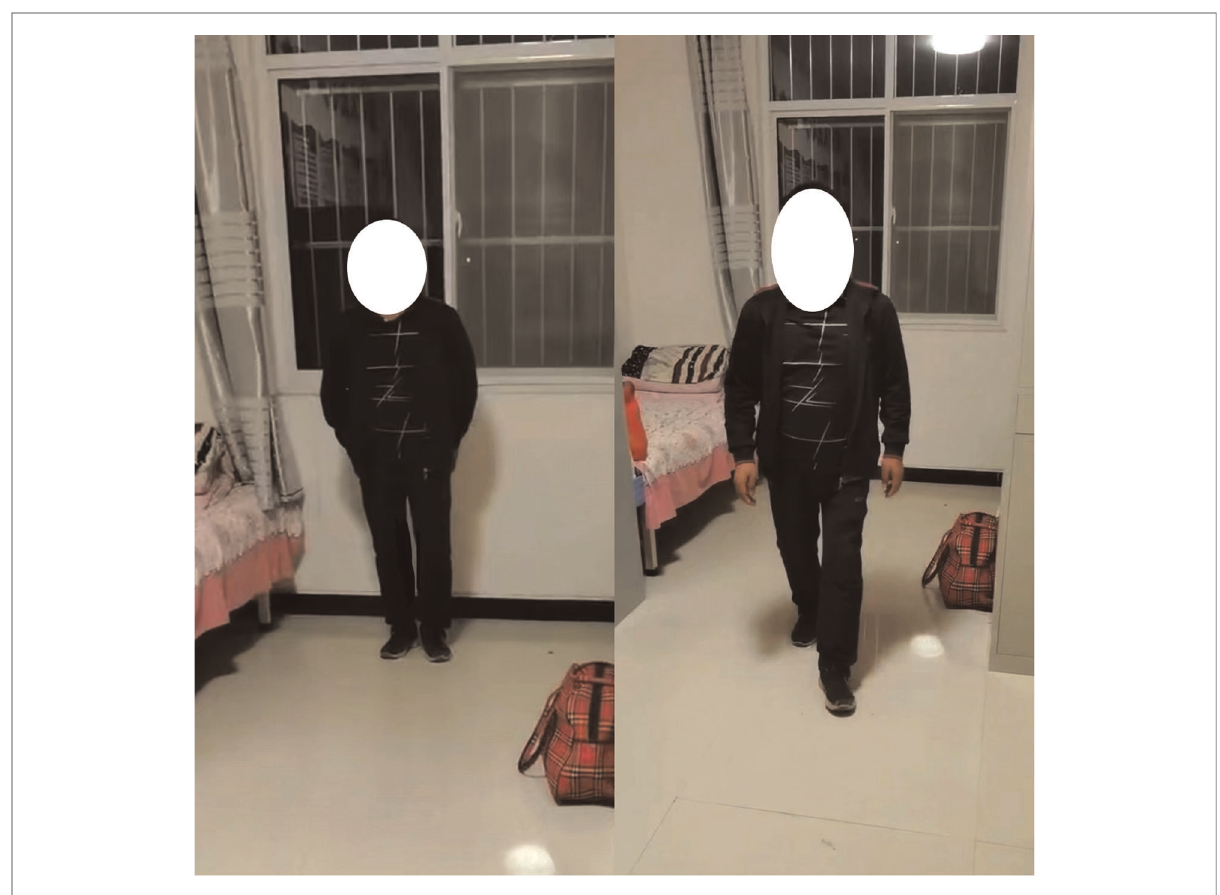
FIGURE 4 The Patient ’ s standing and walking 1 month after surgery. (Figure notes: The patient ’ s postoperative hip movement improved signi fi cantly and his gait was